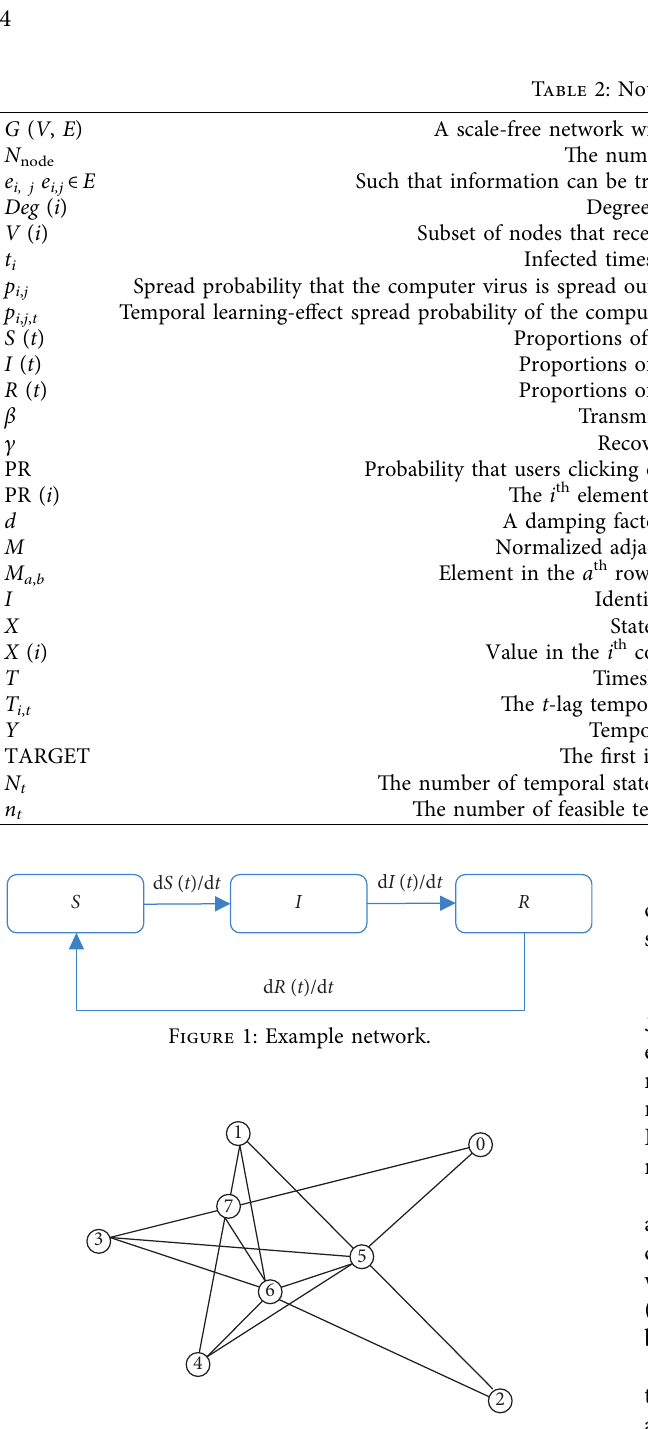
Figure 2: Example